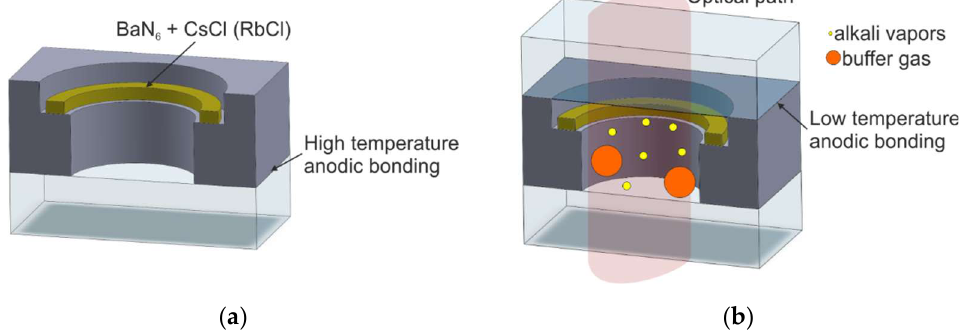
Figure 6. Fabrication process utilizing on-chip chemical reaction: ( a ) silicon–glass preform with BaN 6 + CsCl (RbCl) ring, ( b ) cross section of the cell.